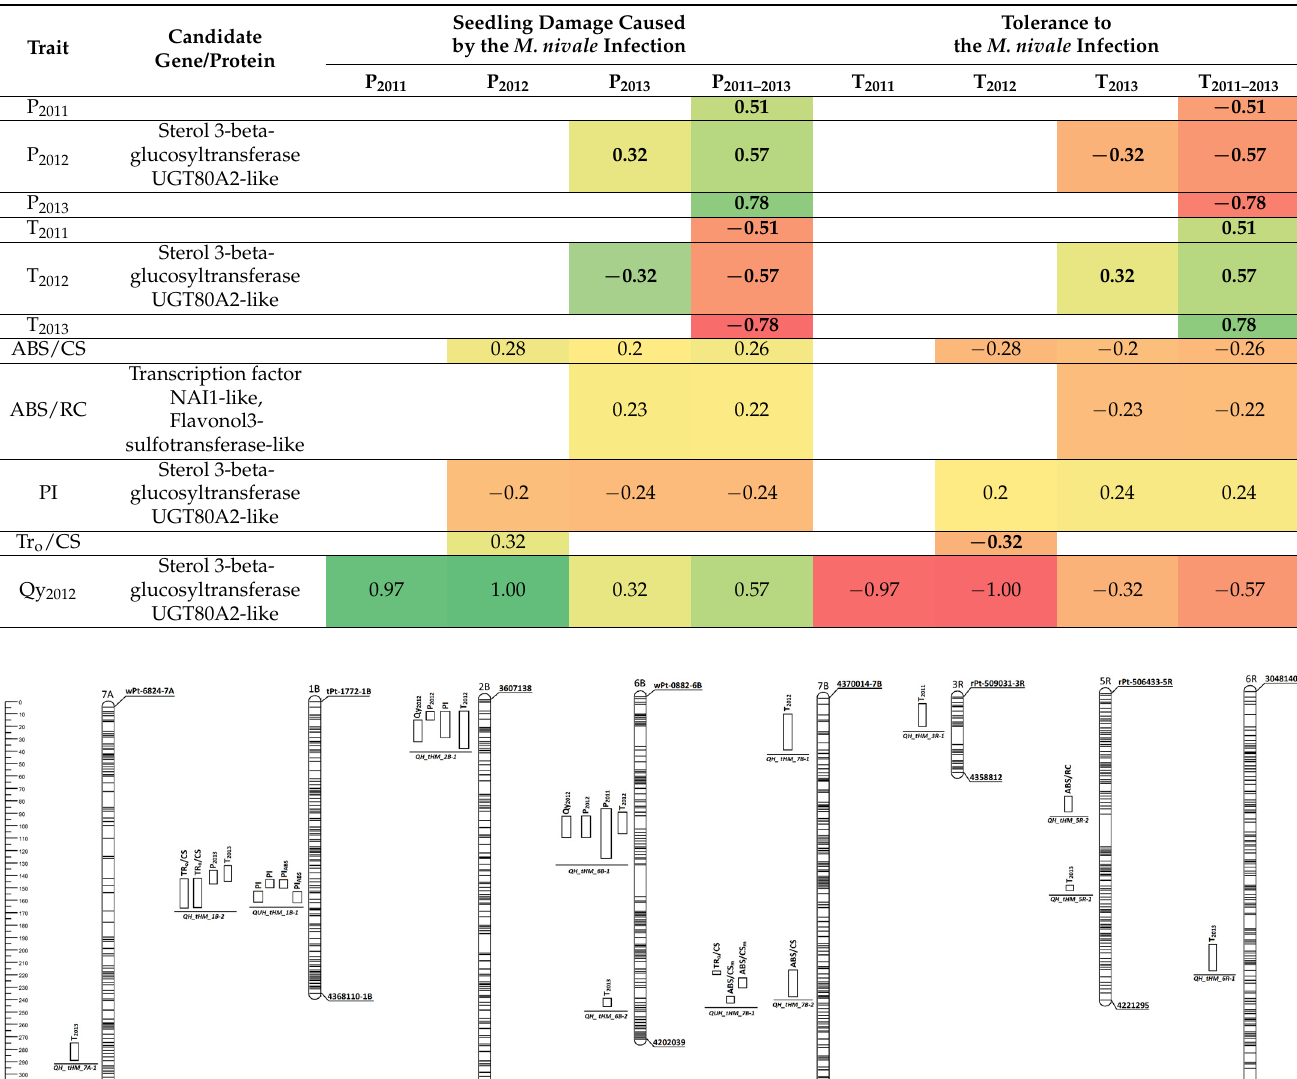
Table 3. Significant correlation between the seedling damage caused by the M. nivale infection and the selected traits evaluated in cold-hardened winter triticale seedlings of ‘Hewo’ x ‘Magnat’ DH lines. Trait